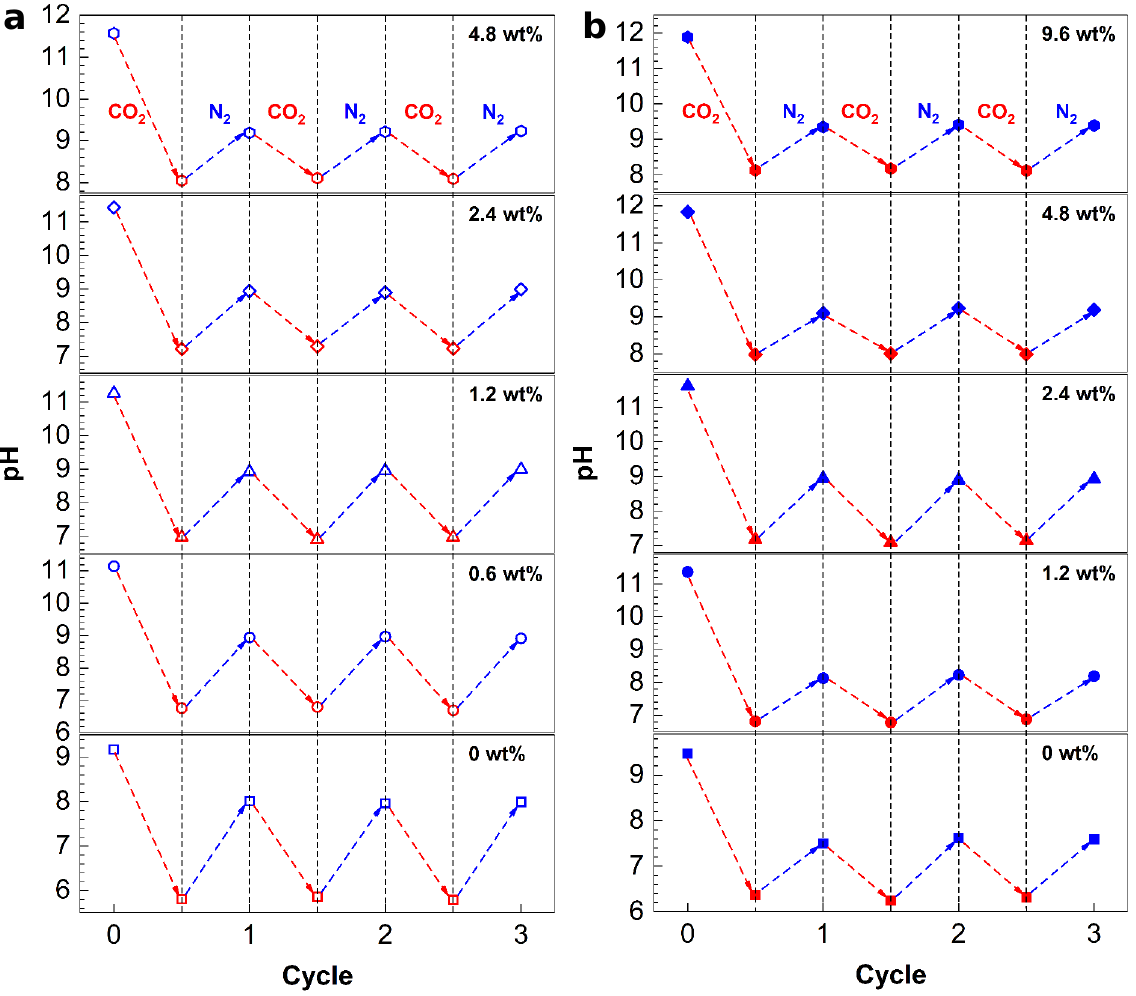
Figure 7. Variation of pH for ( a ) 0.65 wt% and ( b ) 1.30 wt% NaPAA solution at different DMEA concentration while alternatively bubbling CO 2 and N 2 at 25 °C.